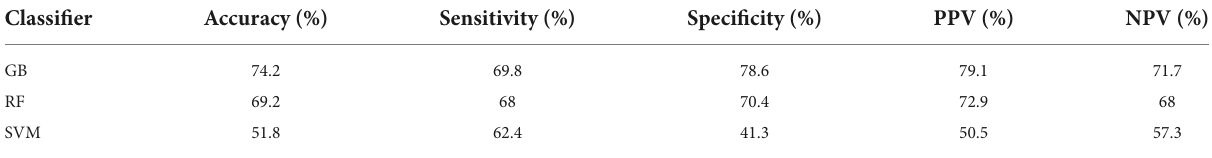
TABLE 3 Classification performance of three different classifiers using a subset of optimal features, extracted from rs-fMRI using AAL atlas after assessing the contribution of circular analysis.